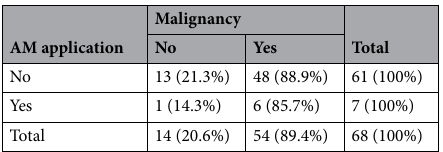
Table 3. A group of 68 patients/AM application versus